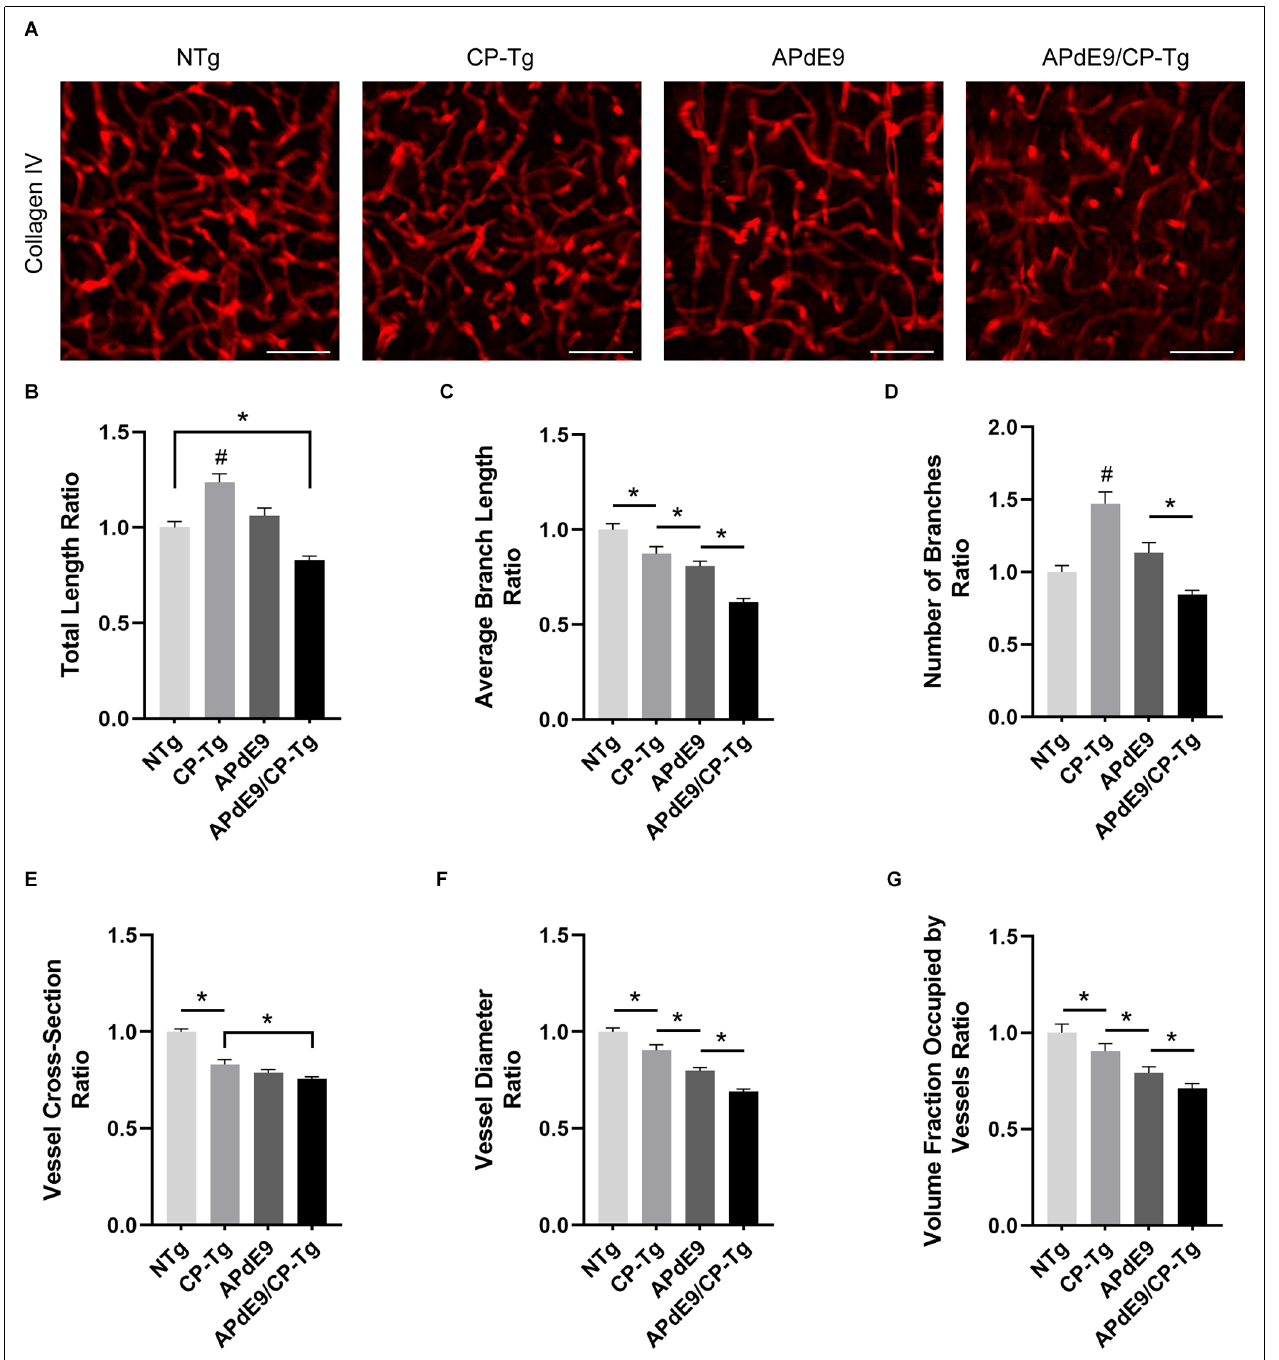
FIGURE 8 | Cerebral vasculature structures are damaged by prostacyclin overexpression in APdE9/CP-Tg mice. Quantification of vascular structures, by collagen IV staining, in the cortex of 17–20-month-old NTg, CP-Tg, APdE9, and APdE9/CP-Tg mice. (A) 40 × 60 µ m thick confocal image stacks of collagen IV-positive microvessels were used for vessel tracing analysis. Scale bar = 50 µ m. (B) APdE9/CP-Tg mice had significantly fewer vessels compared to NTg or CP-Tg and APdE9 mice, while CP-Tg mice had significantly more. (C) APdE9/CP-Tg mice had significantly fewer number of vessel branches compared to NTg or CP-Tg and APdE9 mice, while CP-Tg mice had significantly more. (D) Branch length is significantly reduced in all models compared to NTg mice; CP-Tg mice show the least reduction in length while APdE9/CP-Tg mice show the greatest. (E,F) Cortical vessel cross-section and diameter were significantly smaller in all models compared to NTg mice with APdE9 mice exhibiting the greatest amount of smaller, constricted vessels. (G) Of the volume of vessels imaged for each genotype, NTg mice maintained the greatest fraction of vessels imaged while APdE9/CP-Tg mice contained the fewest. (B–G) All measures are a ratio of total vessel volume imaged by genotype and set to a normalized scale where control equals 1. * p < 0.05; # p < 0.05 compared to NTg, APdE9, and APdE9/CP-Tg mice. Bars are means ± SEM, n = 5 mice per group.